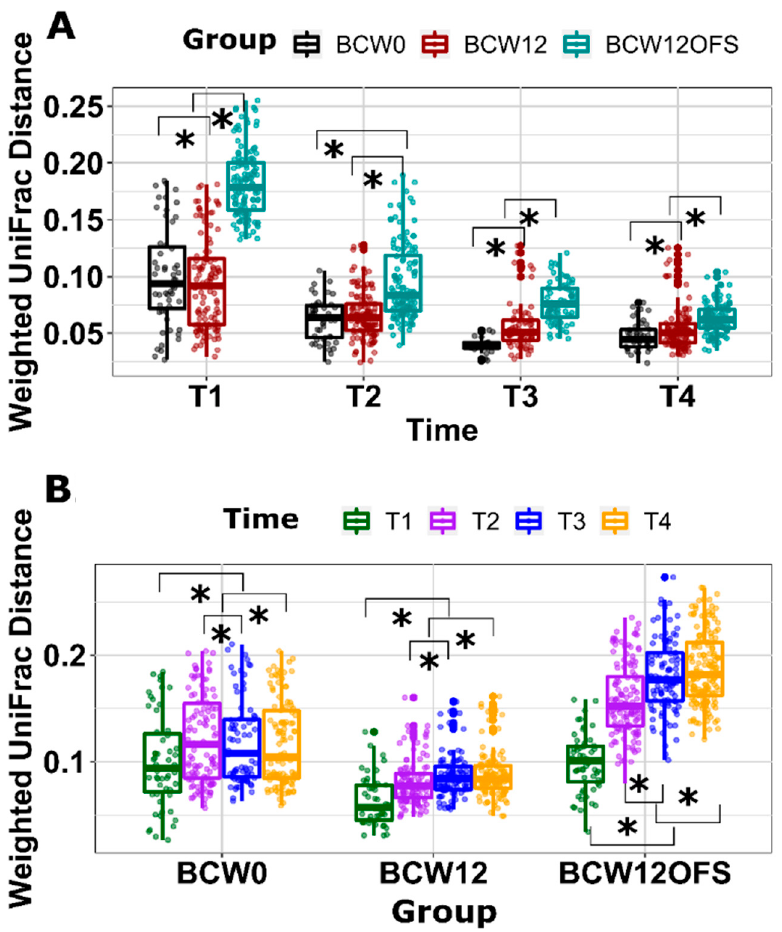
Figure 9. Mouse gut microbial beta diversity across time points. Beta diversity as measured by Weighted UniFrac Distance at T1 (day 5—post ‐ FMT), T2 (day 13—post tumor cell injection), T3 (day 22—post paclitaxel), and T4 (day 27/28—euthanasia) and analyzed using ANOSIM to detect signif ‐ icant between ‐ group community differences at each time are presented ( A ). Weighted UniFrac Dis ‐ tance analyzed with ANOSIM to detect community differences over time within each group are also presented ( B ). * indicates a significant difference ( p < 0.05). Data are presented as ± SEM.